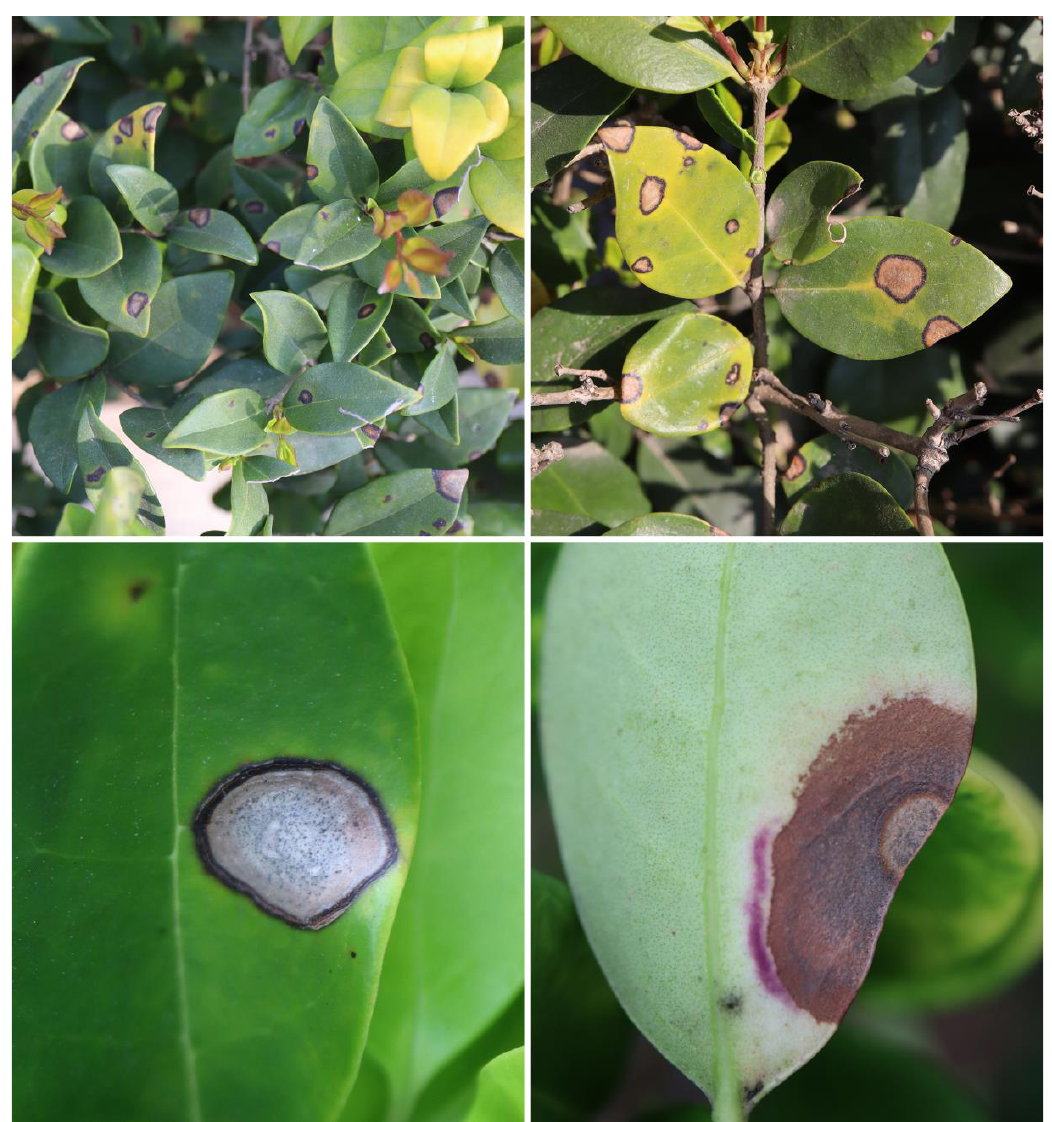
Figure 1. Symptoms of leaf spots on Ligustrum japonicum